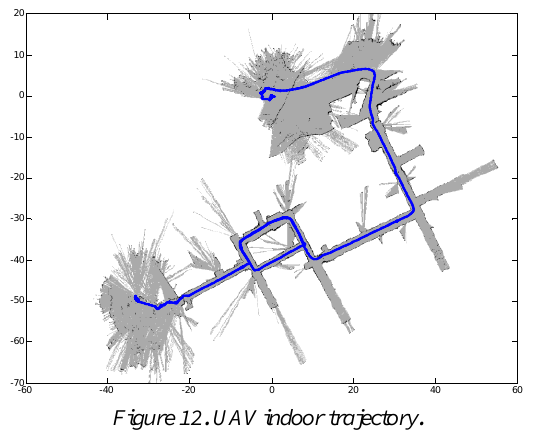
Figure 12. UAV indoor trajectory.